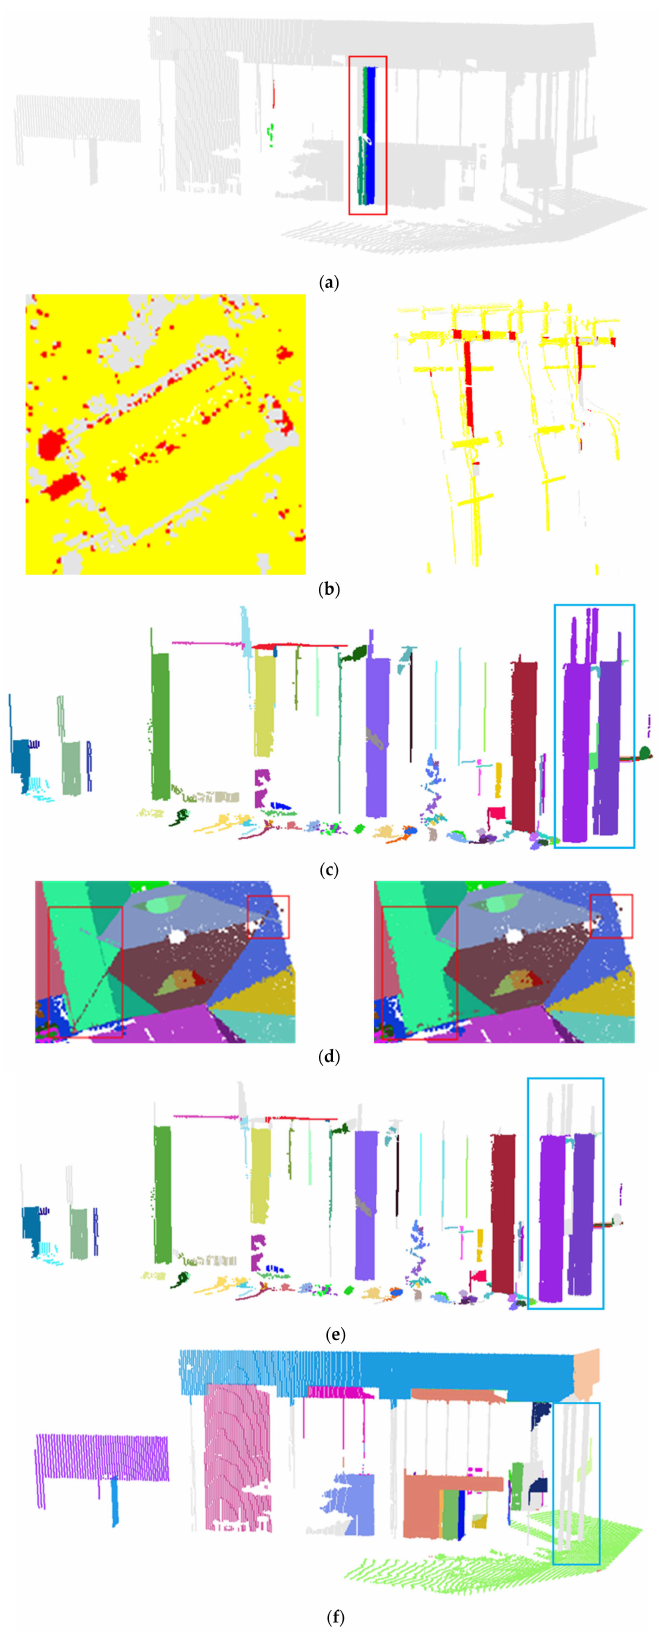
Figure 12. Examples of improved segmentation quality by the different QC measures. ( a ) After QC1: reclassified pole-like features; ( b ) After QC2: Interclass competition (planar and pole-like); ( c ) After QC3: Over-segmentation (pole-like); ( d ) Before and after QC4: Intraclass competition (planar); ( e ) After QC5: Misclassified pole-like; ( f ) After QC6: Misclassified